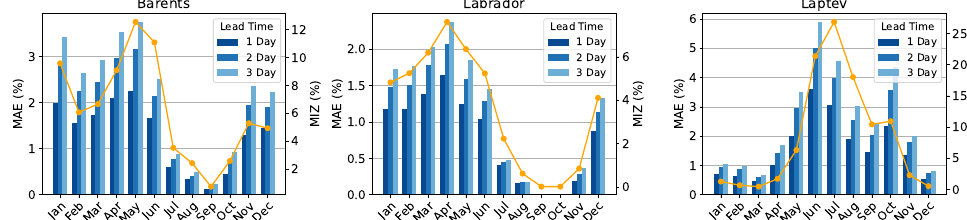
Figure 8. General U-Net (R) with GFS: distribution of JAXA SIC MAE (lower is better) for different months of 2021 and days of the forecast. The orange line shows the marginal ice zone area relative to the region’s sea